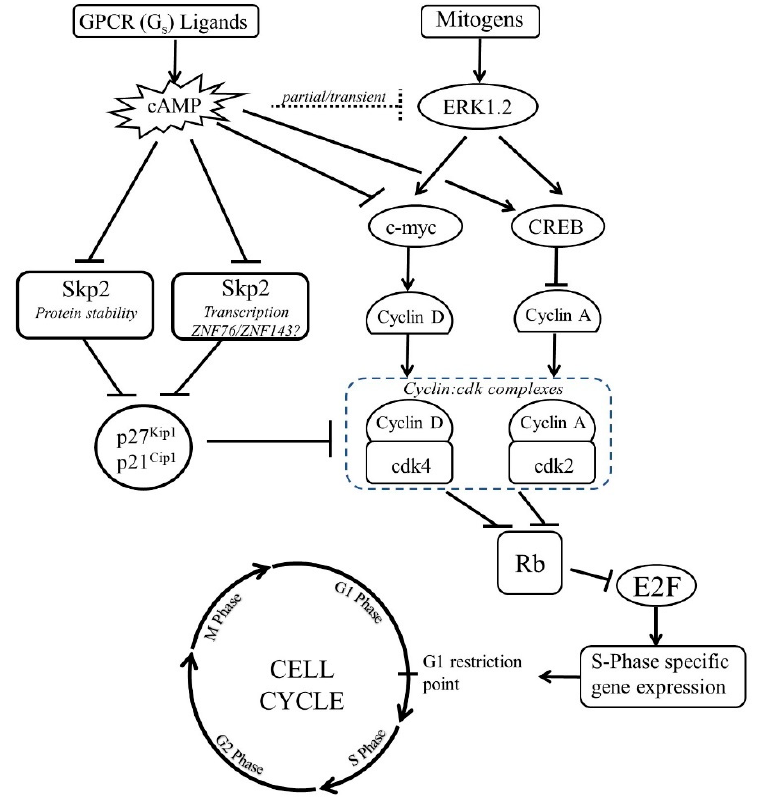
Figure 1. Cell cycle regulation by cAMP in VSMC. In VSMC, elevated cAMP inhibits S-phase entry. S-phase entry is controlled by retinoblastoma protein (Rb, which represses E2F-dependent gene expression. Rb inactivation requires phosphorylation by cdk enzymes, which are dependent on binding to cyclin proteins for catalytic activity. Expression of cyclin-A and -D is repressed by cAMP, via reductions in c-myc expression and activation of CREB respectively. Activity of cyclin:cdk complexes is inhibited by CDKIs, including p27 Kip1 and p21 Cip1 . Levels of p27 Kip1 and p21 Cip1 are reduced in late G 1 phase via Skp2-mediated ubiquitination and proteasomal degradation. Skp2 levels normally increase in late G 1 to remove this brake on cdk activity. However, cAMP represses induction of Skp2, which increases p27 Kip1 and p21 Cip1 levels. This reduction in cyclin expression and increase in CDKI levels, prevents phosphorylation of Rb and entry into S-phase.